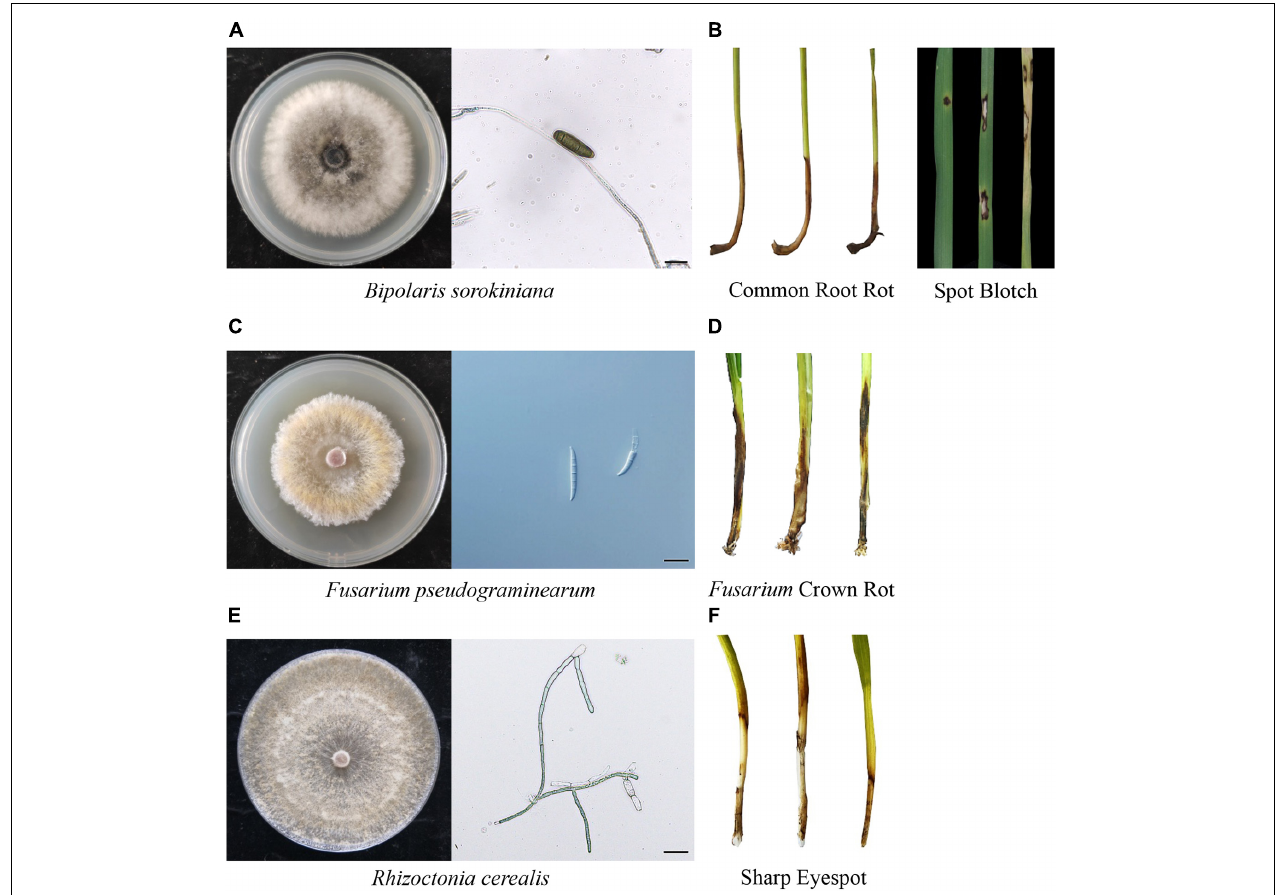
FIGURE 1 | Pathogenic profiles of Bipolaris sorokiniana , Fusarium pseudograminearum , and Rhizoctonia cerealis . (A) B. sorokiniana was cultivated on potato dextrose agar (PDA) medium and spores were directly collected. (B) Common root rot and spot blotch caused by B. sorokiniana . Infected wheat plants were easily pulled out, the stem base and root system felt wet, and black and brown striped spots can be observed in both the stem base and lower leaves. (C) F. pseudograminearum cultivated on PDA medium. Spores of F. pseudograminearum can be induced on carboxymethyl cellulose sodium (CMC) medium. (D) Fusarium crown rot caused by F. pseudograminearum . The stem base of infected wheat plants became dry and fragile, and was easily broken apart. Additionally, dark and red brown rot can be observed in the stem base. (E) R. cerealis was cultivated on PDA medium. (F) Sharp eyespot caused by R. cerealis . The typical lesions on wheat stem are elliptical or exhibit an “eye” shape with sharply dark brown borders. Scale bar = 20 µ